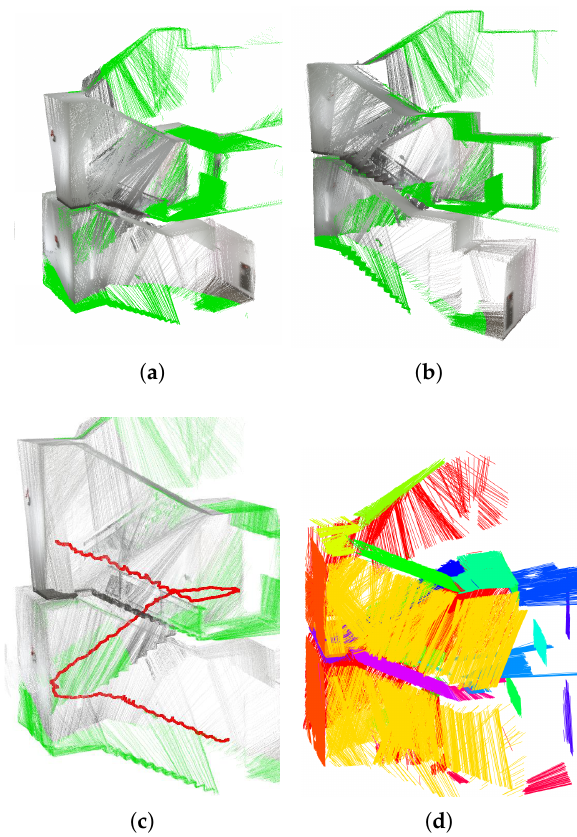
Figure 9. Reconstruction results: ( a , b ) 3D reconstruction results using the proposed method; ( c ) estimated trajectory (red dots) of the sensor system with 3500 scans down the stairs; and ( d ) scanned line segments displayed in colors of corresponding